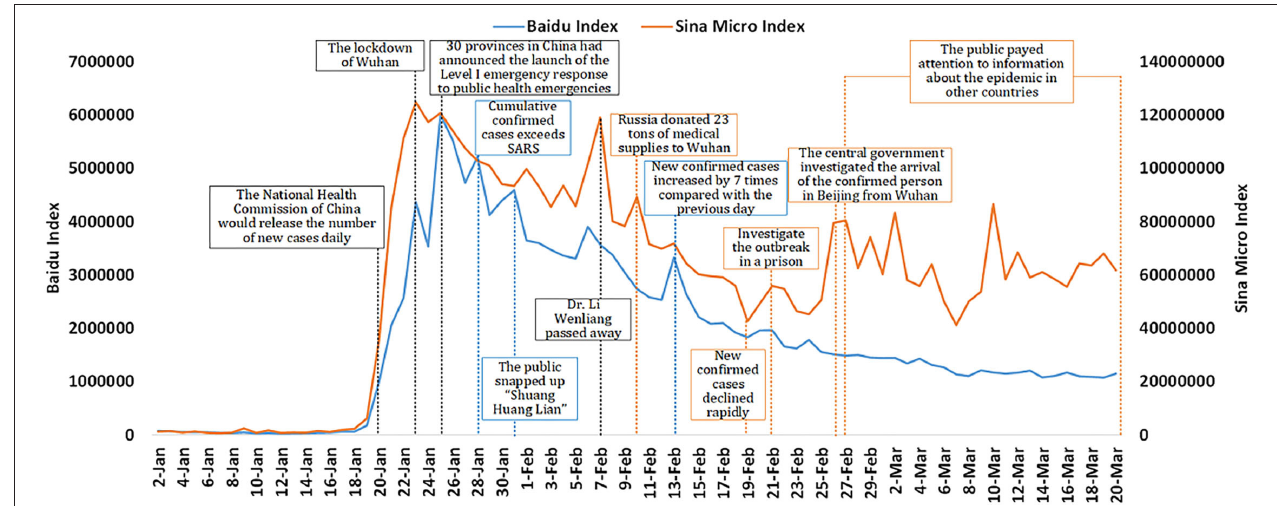
FIGURE 2 | The changing trend of the Baidu Index and Sina Micro Index of COVID-19 in China from January 2 to March 20 in 2020. Blue explains the Baidu Index, orange explains the Sina Weibo Index, and black explains both.